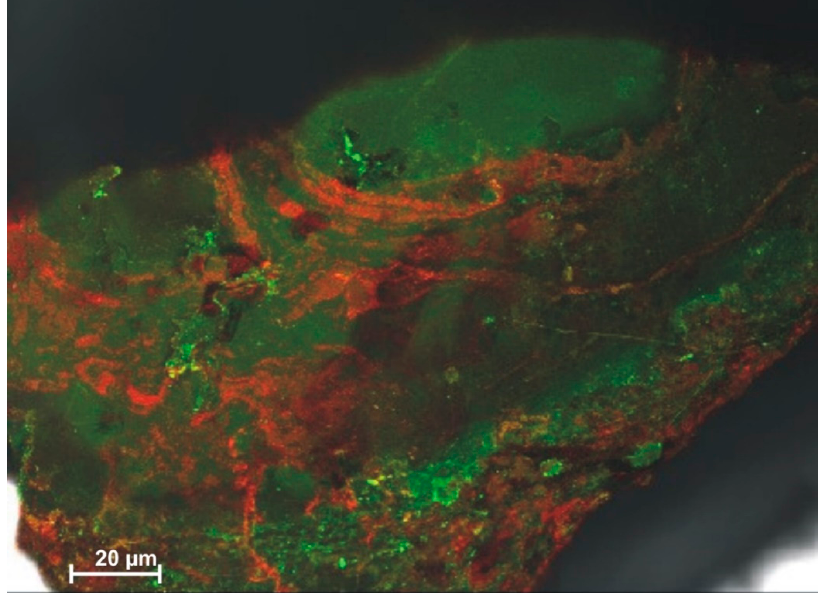
Figure 7. CLSM photograph of the biofilm after 5 days of plaque growth showing scattered areas with live (green) and dead (red) bacteria. There are mainly living bacteria with scattered strains of dead bacteria.